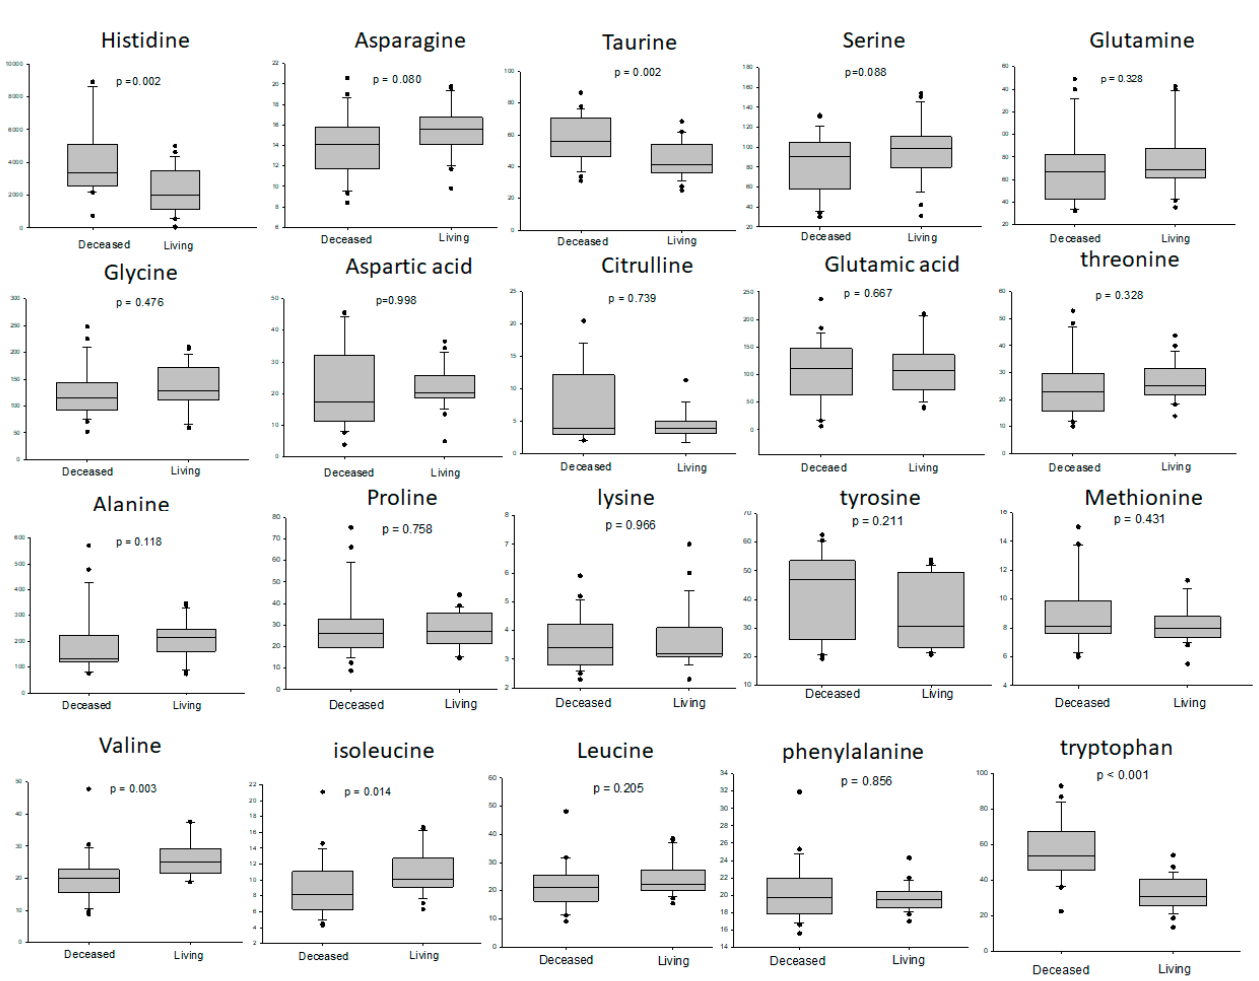
Figure 4. The difference of amino acid in deceased and living donor liver grafts. The deceased livers had higher levels of histidine, taurine and tryptophan than living donor livers, and living donor livers had a higher level of valine than deceased livers.